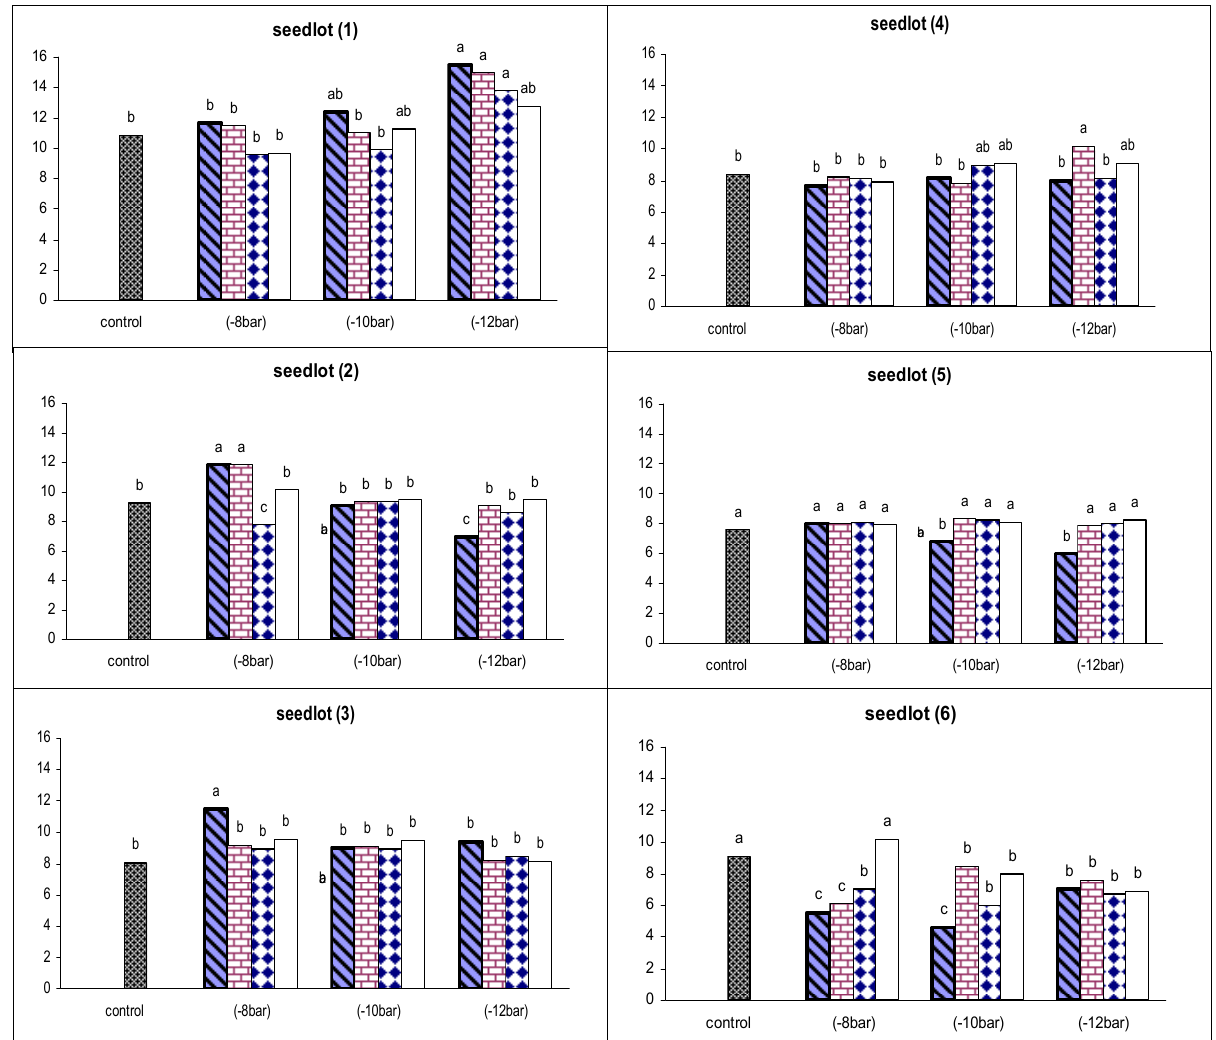
Fig. 4. Influence of osmotic potential levels of osmopriming treatments on the seedling length (SL) in soybean seed lots (cv. ‘Sari’) under 12 , 24 , 36 and 48 hours durations. Horizontal axe shows priming with -8 bar; -10 bar; -12 bar; polyethylene glycol and 0 bar as a control group . Vertical axe is seedling length